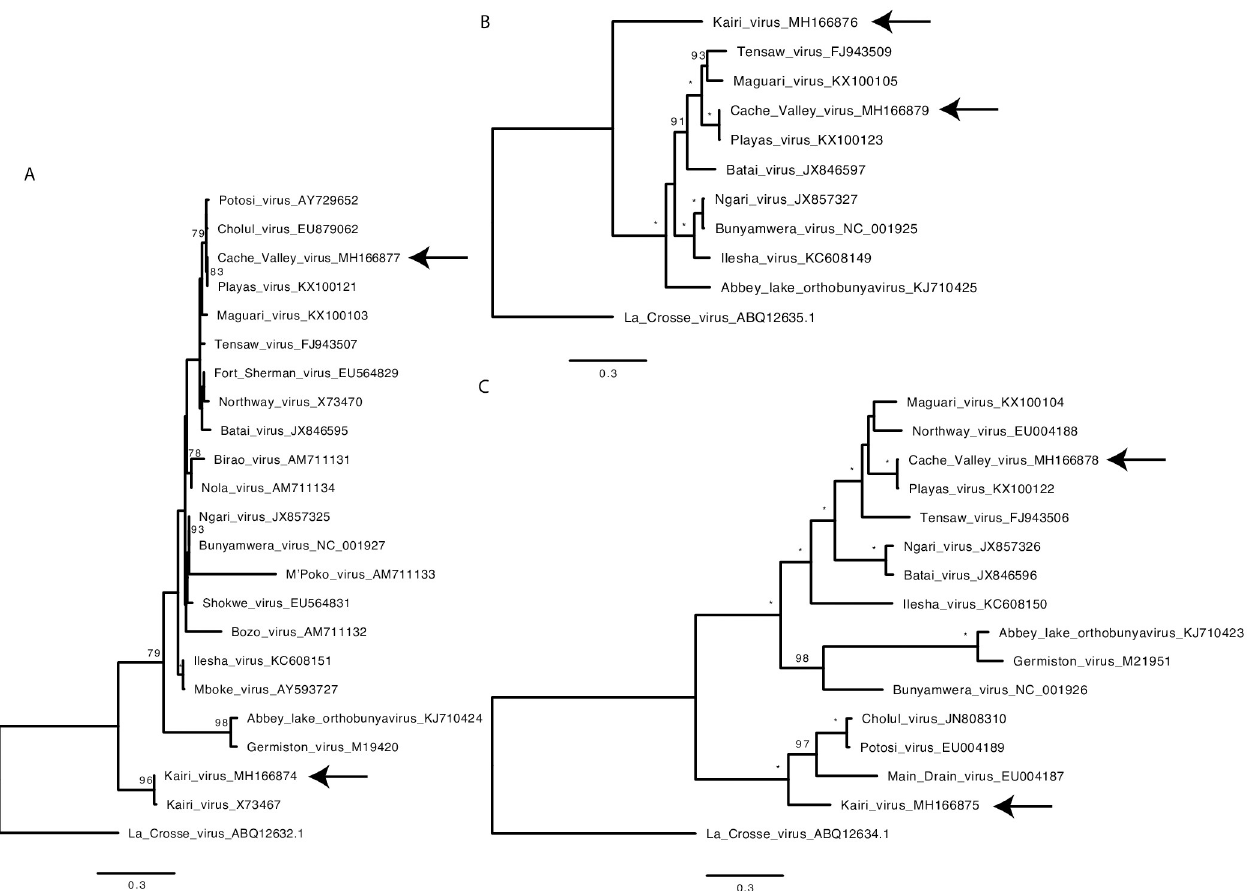
Fig 6. Phylogenetic analysis of selected viruses from the Bunyamwera serogroup with the newly acquired sequences from CVV (6V633) and KRIV (TR8900). The bootstrap supports shown at the nodes on the phylogeny ( � represents 100 percent bootstrap support) and La Crosse virus (California serogroup) was used as an outgroup: (A) nucleoprotein N (from S segment) using the JTT+G substitution model, (B) RNA dependent RNA polymerase (from L segment) using the LG protein substitution model and (C) the M segment open reading frame (encoding glycoproteins and NSm) using the FLU+I+G+F substitution model. The arrows on the phylogeny indicate the phylogenetic position of the newly sequenced full genomes.